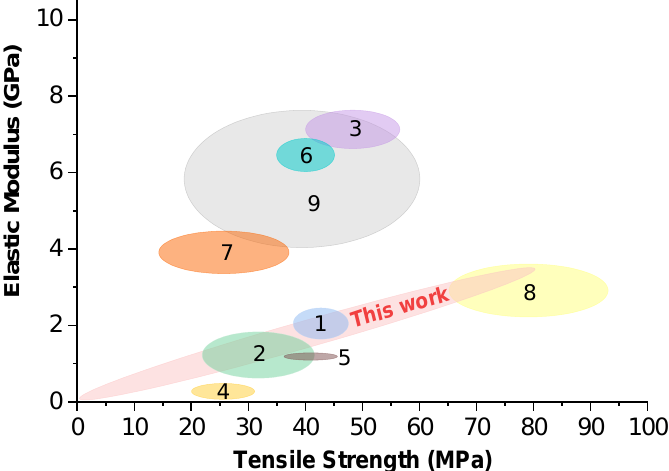
Figure 12. Elastic modulus and tensile strength map to compare CNPs prepared by similar studies from the literature. (1) MFC/lignin/xylan film [40]. (2) Microcellulose/hydrolysed lignin/xylan film [50]. (3) Carboxymethylated NFC/Xylan NP [51]. (4) Xylan/carboxymethyl cellulose (CMC), oxidized carboxymethyl cellulose (OCMC) and cellulose nanofibers (CNFs) film [33]. (5) Bacterial cellulose nanofibrils and nanocrystals film [77]. (6) Bleached and unbleached pistachio shell MFC film [78]. (7) Cellulose nanowhiskers (CNW) and NFC nanopapers [79]. (8) Acetylated rye arabinoxylan (AcAX)/NFC films [80]. (9) Sugarcane bagasse NFC films [81].